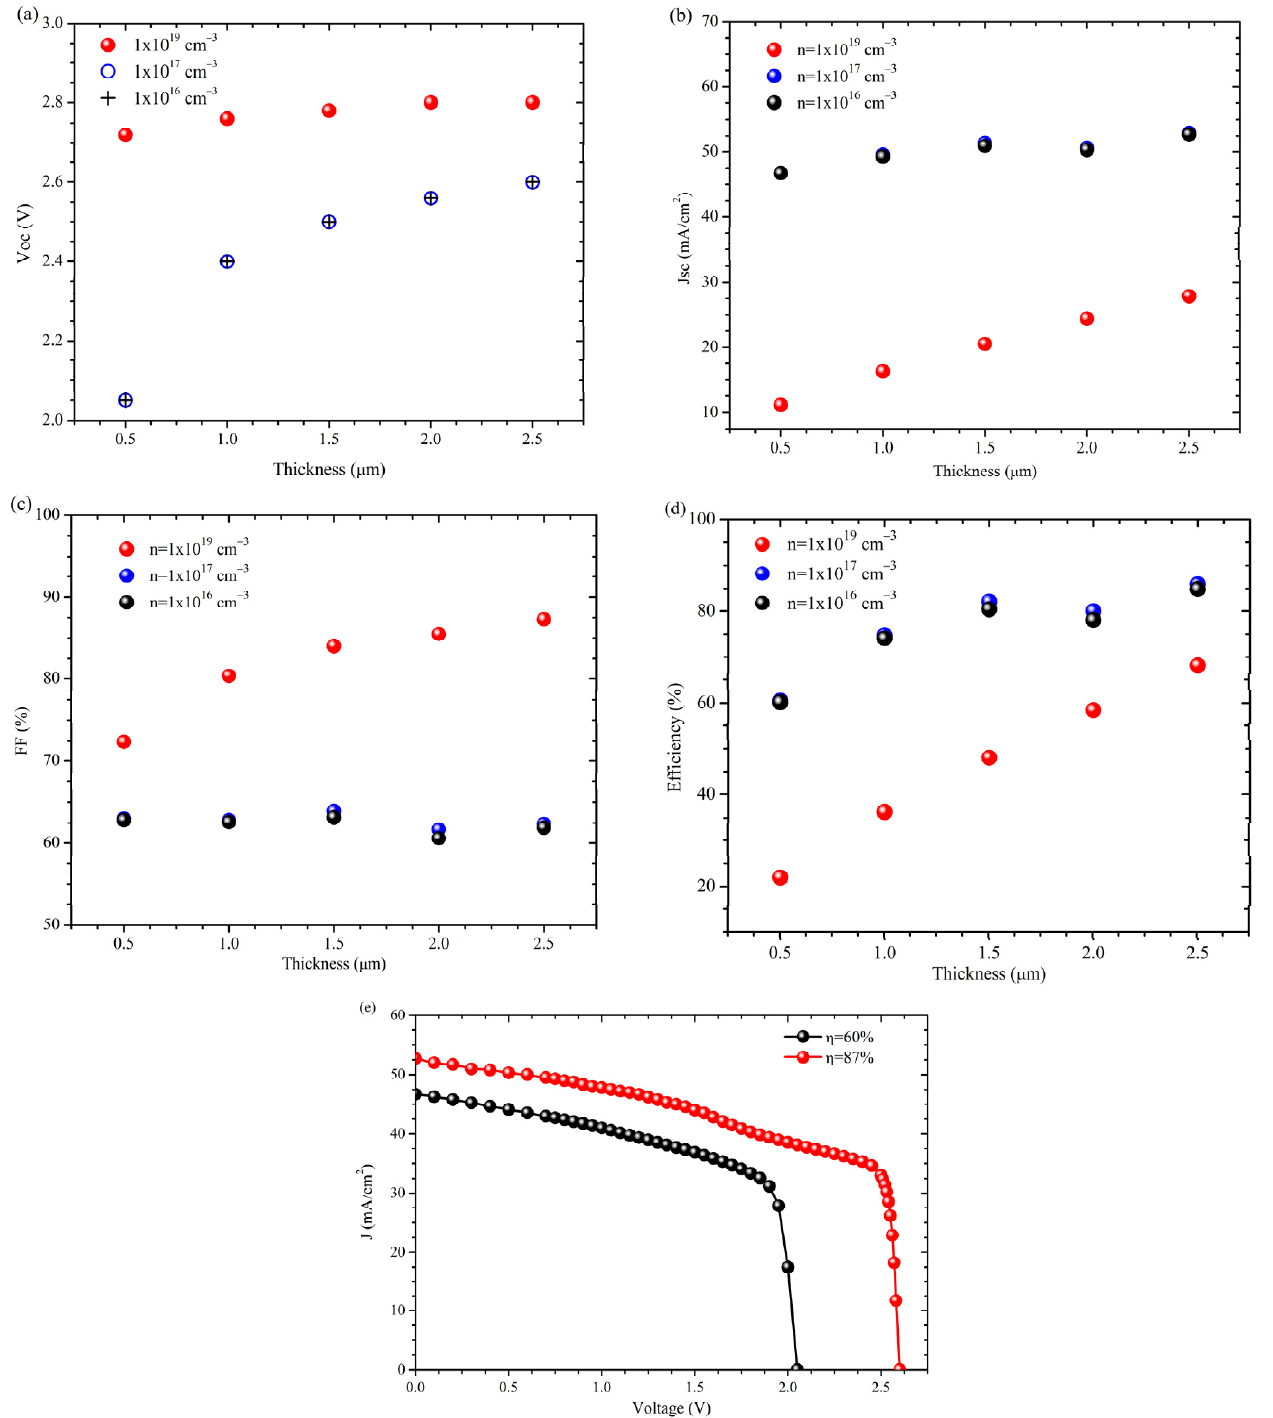
Figure 9. Summary of results for step-graded InGaN-based solar cell. ( a ) Open-circuit voltage, ( b ) current density, ( c ) fill factor, ( d ) efficiency, and ( e ) J-V curves for lowest and highest efficiencies for n = 1 × 10 17 cm − 3 in the absorber layer.